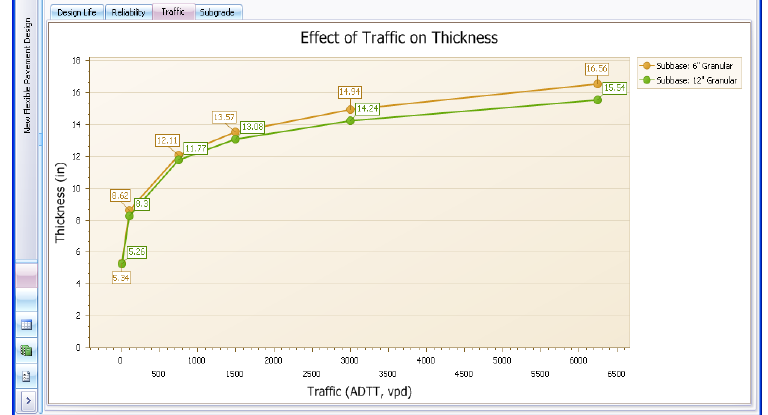
Figure 10. Screenshots of sensitivity analysis of traffic on asphalt pavement thickness.